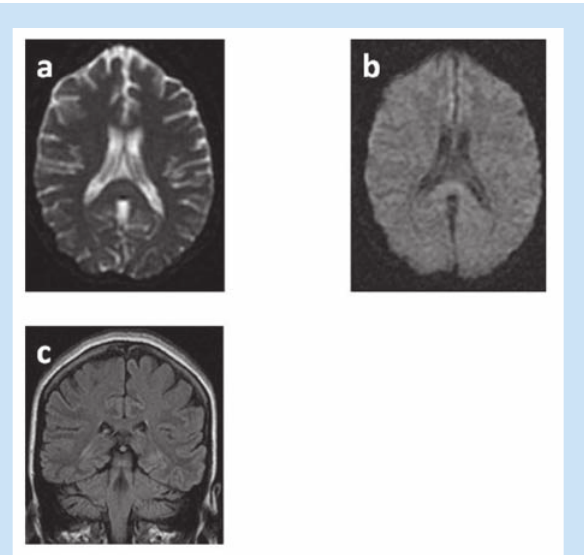
Fig. 1. Cranial MR images demonstrate a focal non-enhancing corpus cal- losum splenial lesion (arrow). (a) Sagittal T1-weighted image shows swell- ing of splenium of the corpus callosum with T1 prolongation. (b) Lesion in the splenium is hyperintense on axial T2-weighted turbo spin echo. (c) Hyperintense on the coronal FLAIR image.